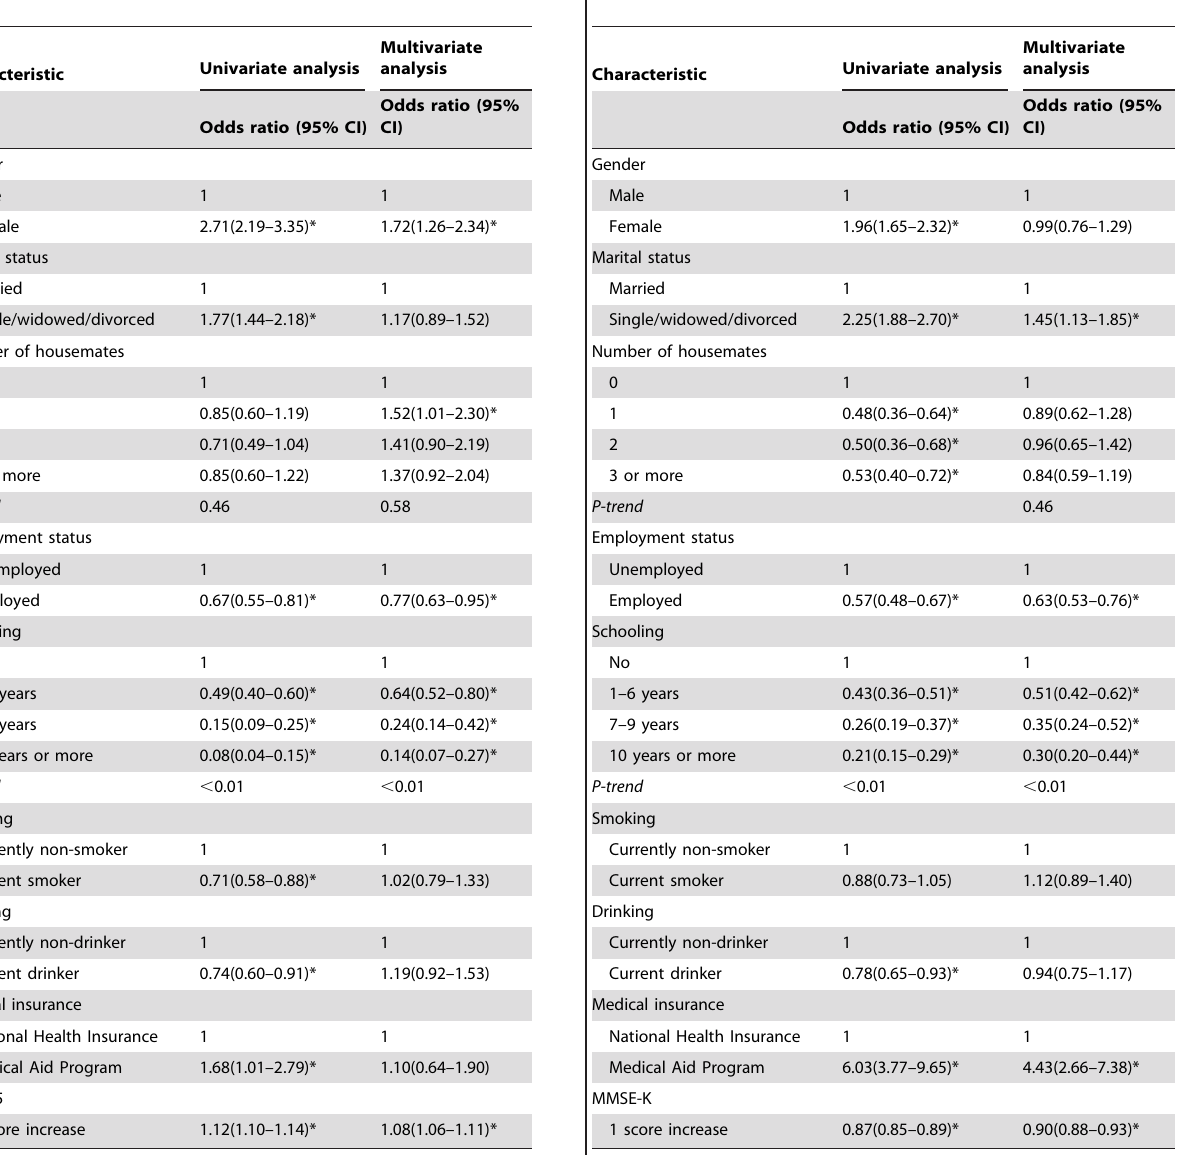
Table 2. Associations between socio-demographic variables and cognitive impairment in adults aged 60-64 living in a rural area, Korea.